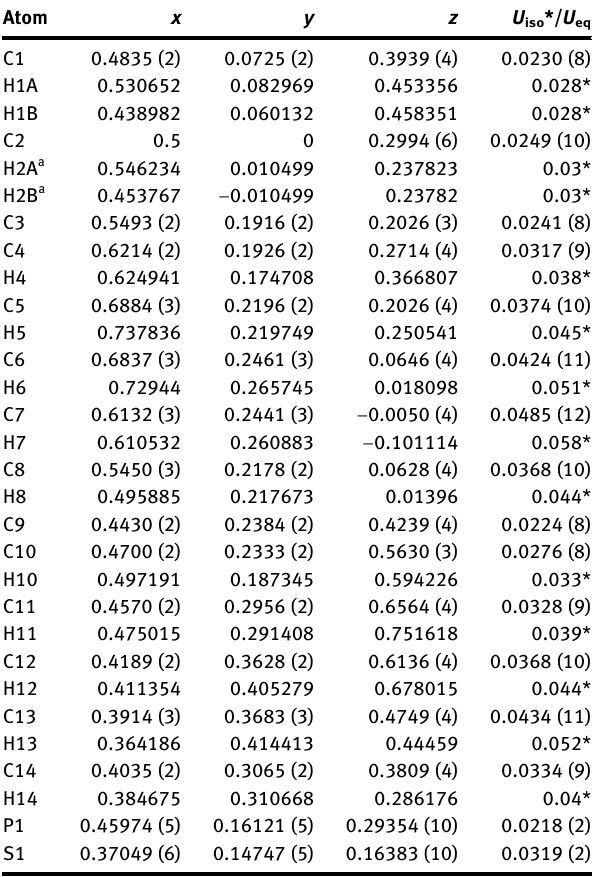
Table  : Fractional atomic coordinates and isotropic or equivalent isotropic displacement parameters (Å 